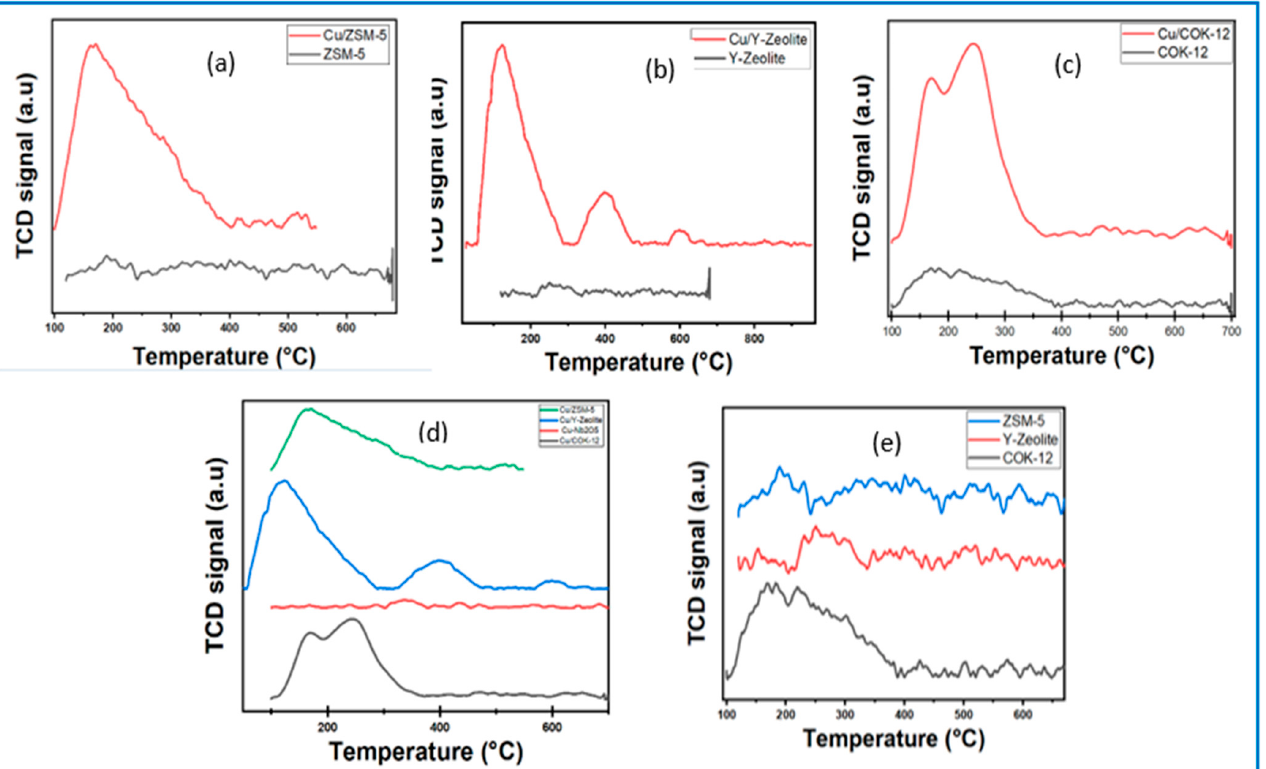
Figure 10. NH3-TPD profiles of ( a ) Cu-ZSM5 and ZSM5, ( b ) Cu-Y-Zeolite and Y-Zeolite ( c ) Cu/COK12 and COK12 ( d ) Cu mod-ified COK12, Nb2O5, Y-Zeolite, and ZSM5 catalysts, and ( e ) ZSM5, Y-Zeolite and COK12 support.